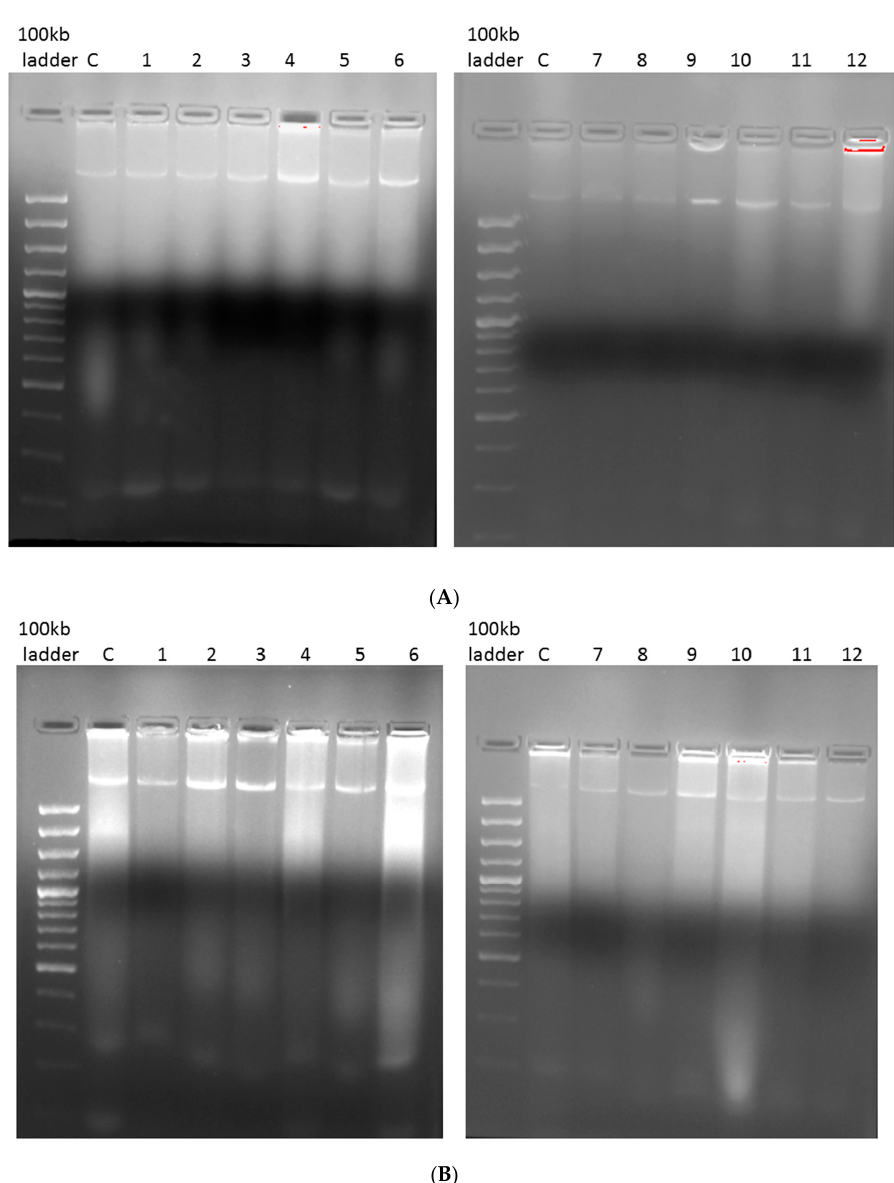
Figure 6. DNA fragmentation assay of the extracts of M. peregrina . ( A ) Treatment on Caco-2 cells, ( B ) treatment on MCF-7 cells. Lanes: C—control, ‘1’—hexane extract (tubers); ‘2’—chloroform extract (tubers); ‘3’—acetone extract (tubers); ‘4’—methanol extract (tubers); ‘5’—hexane extract (leaves); ‘6’—chloroform extract (leaves); ‘7’—acetone extract (leaves); ‘8’—methanol extract (leaves); ‘9’—hexane extract (stem); ‘10’—chloroform extract (stem); ‘11’—acetone extract (stem); ‘12’— Methanol extract (stem).